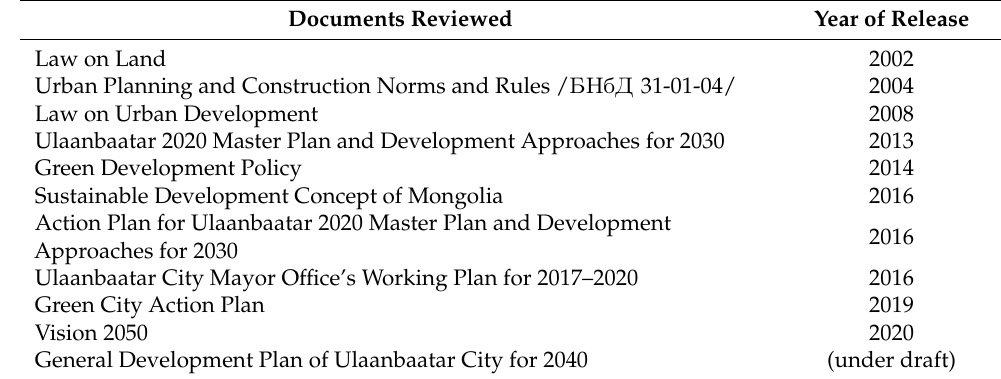
Table 1. Reviewed documents regarding urban green space policy in Mongolia and Ulaanbaatar city.